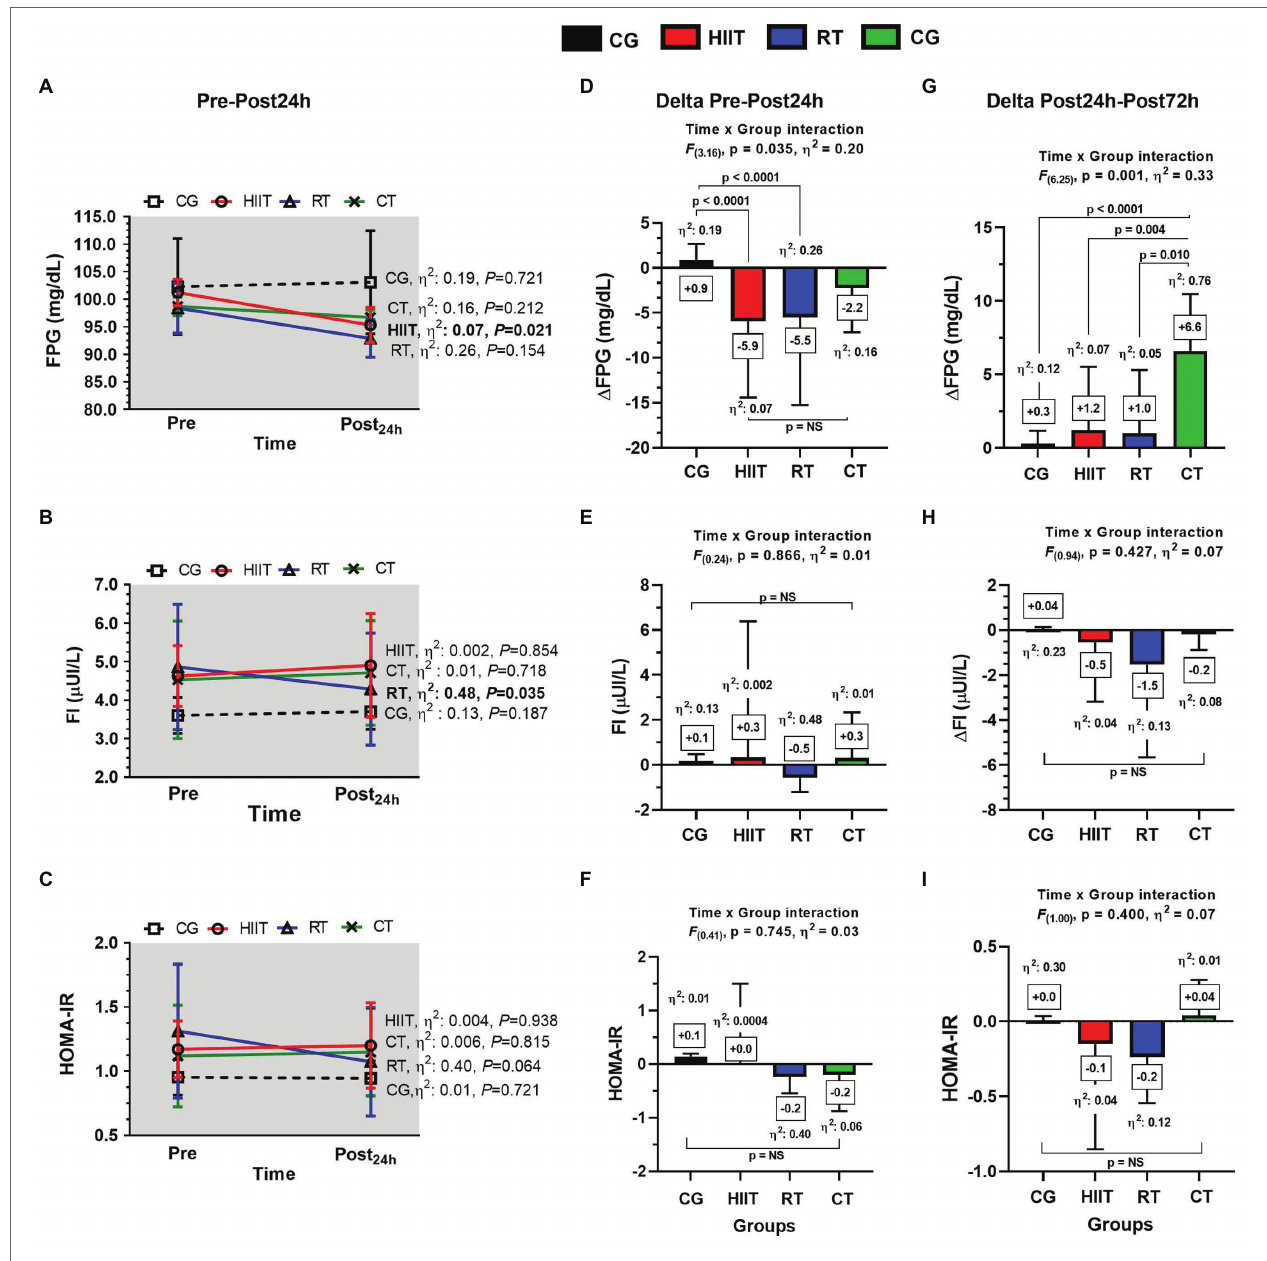
FIGURE 3 | Long-term (A-C) and acute post-24 h (D-F) and post-72 h changes (G-I) in metabolic outcomes in adult women with insulin resistance after 12-weeks of the three different exercise trainings or a control group. Panels (A-C) show values in mean ± SEM during the exercise period. Panels (D–F) show values in “delta changes” (from pre- to post-24 h). Panels (G–I) show values in “delta (Δ) changes” (from post-24 h to post-72 h). Groups are described as: control group (CG), high- intensity interval training (HIIT), resistance training (RT), and concurrent training (CT). Outcomes are described as: fasting plasma glucose (FPG), fasting insulin (FI), and homeostasis model assessment of insulin resistance (HOMA-IR). ∆ FPG 24 h , ∆ FI 24 h , and ∆ HOMA-IR 24 h in panels (D–F) , respectively, denote deltas from pre- to post-test 24 h after the last exercise session. ∆ FPG 72 h , ∆ FI 72 h , and ∆ HOMA-IR 72 h in panels (G–I) , respectively, denote deltas from post-24 h to post-72 h after the last exercise session. Within-group changes are described with specific at values of p ≤ 0.05 in bold in (A,D,G) . Between-group changes are described in bold values in panels (D–I)